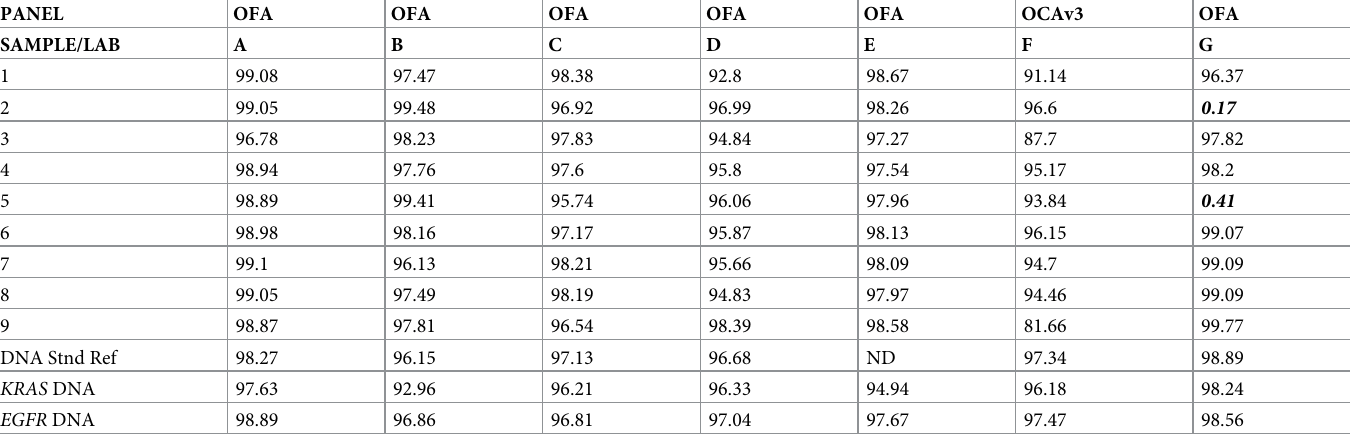
Table 4. Phase 1 DNA uniformity